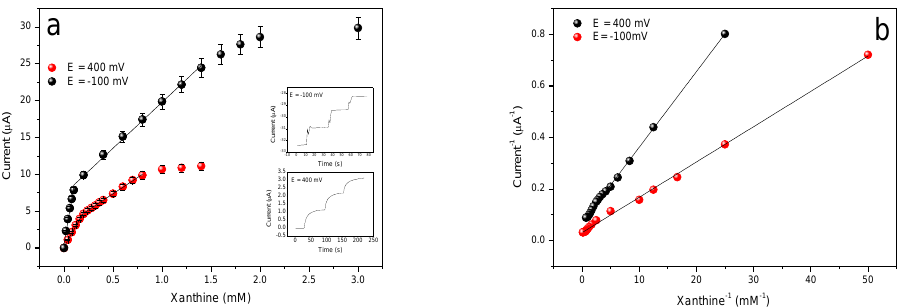
Figure 9. ( a ) Calibration plots obtained at both measuring potentials in stirred oxygen saturated (24 °C) phosphate buffer (pH = 7.0)/NaClO 4 (0.1 M) solution. RDE at 500 rpm. ( b ) Lineweaver–Burk plots at 400 and −100 mV in the same conditions. Each value is the mean result for at least five electrodes. Inset: Amperometric responses of the biosensor to the consecutive addition of 20 μM of xanthine at −100 mV (upper inset) and at 400 mV (bottom inset).